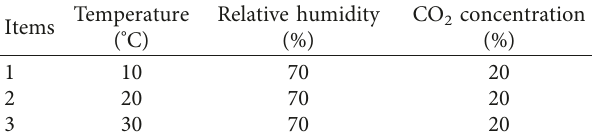
Table 2: Testing condition.